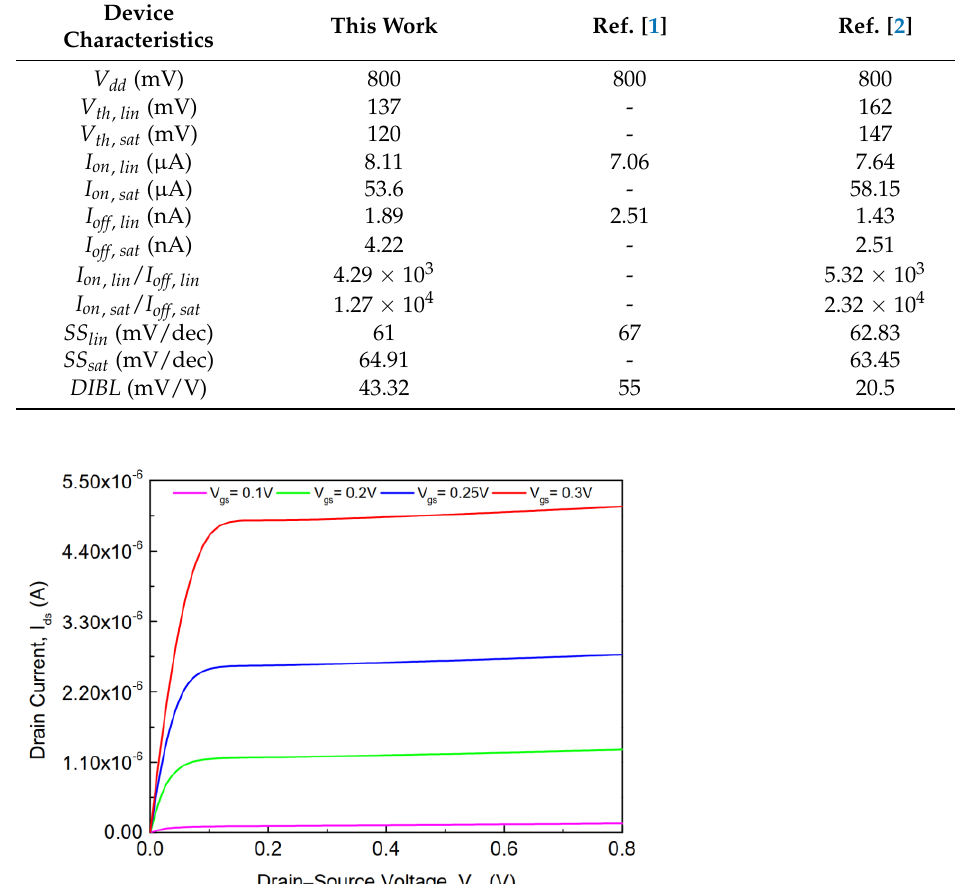
Figure 2. Simulation and experimental I – V curves of the investigated FinFET model [1]. Table 2. Characteristics for the investigated FinFET model.